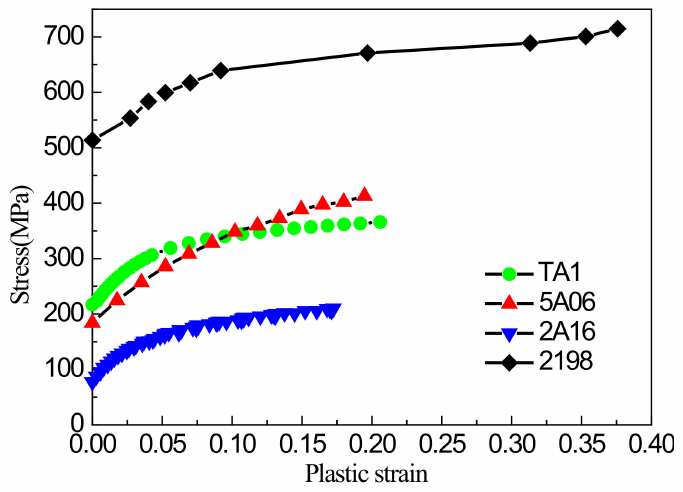
Figure 22. Stress-strain curves of several materials.